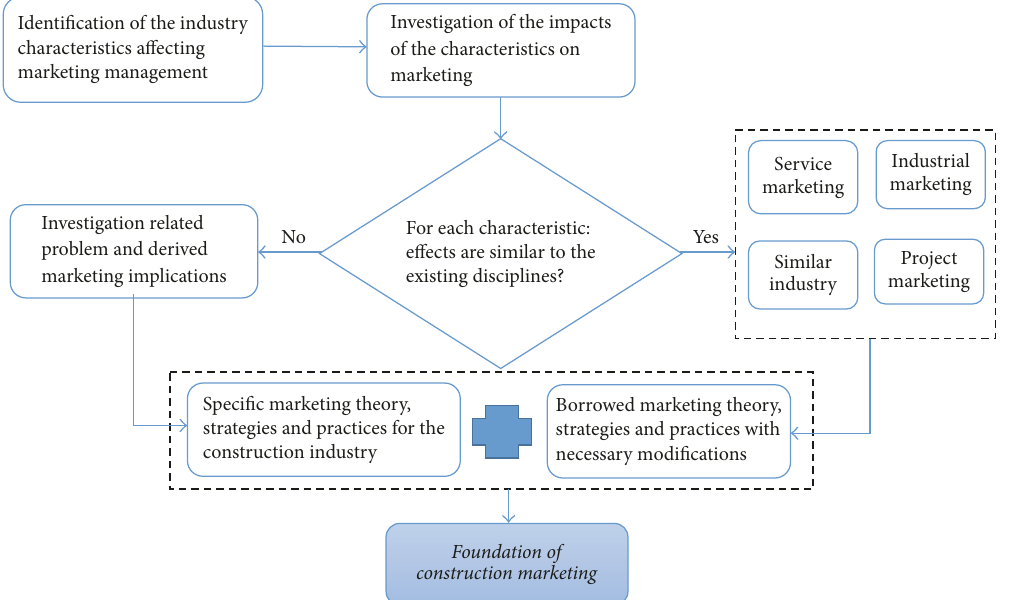
Figure 2: Basic construction marketing knowledge